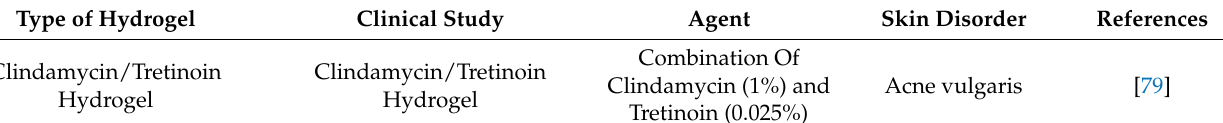
Table 5. Clinical trials of hydrogels in the treatment of skin